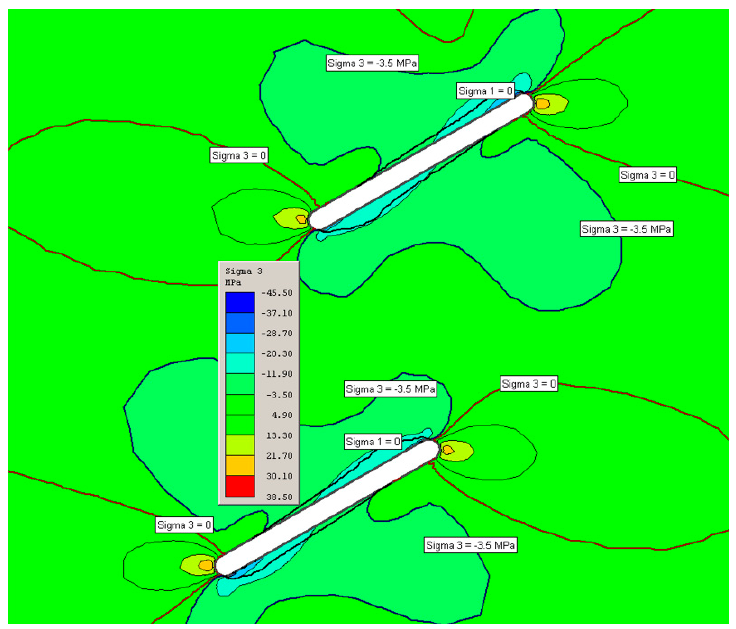
Figure 17. Plot of principal stress for 30-2a-0 geometry.